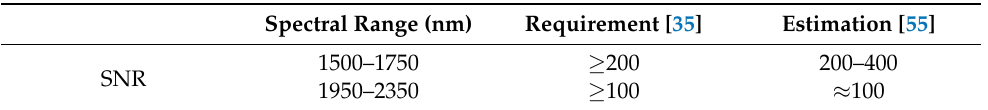
Table 1. Signal-to-noise ratio (SNR) specifications for the PRISMA satellite according to spectral range; requirement specifications come from Labate [35] and the observation-based specifications are estimated in Cogliati